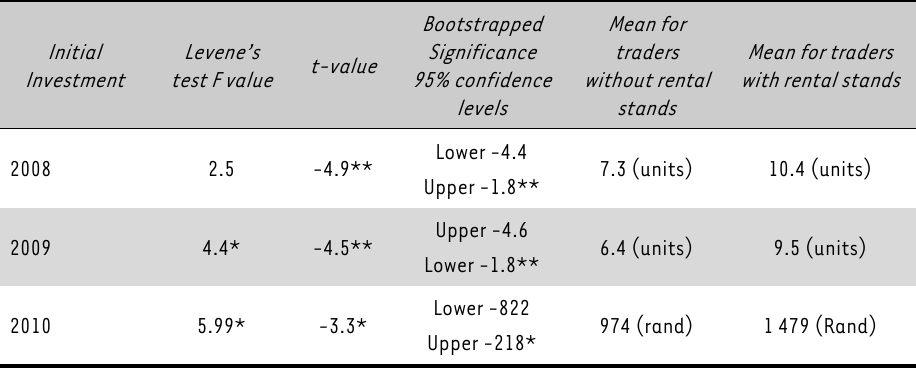
TABLE A2: Results of the t-tests for differences in Initial Investment Initial